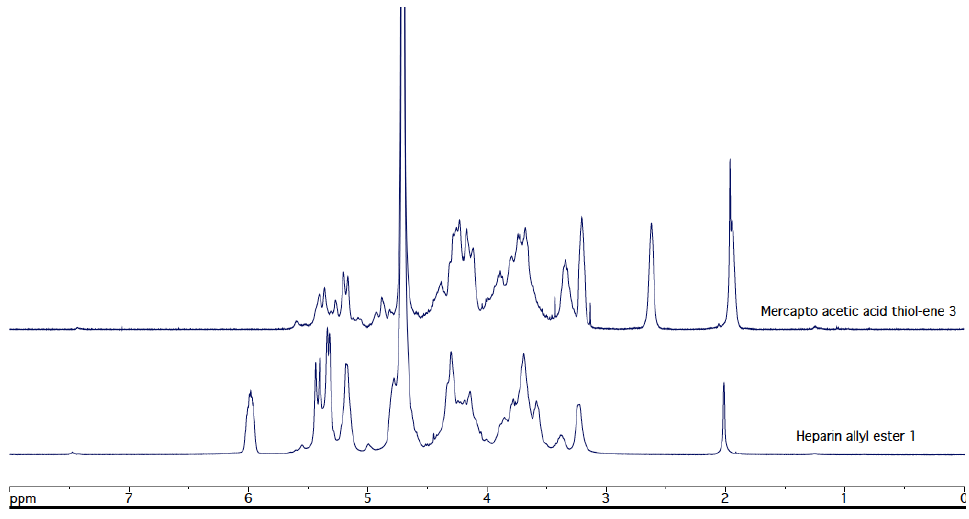
Figure 5. Stacked HNMR spectra of [1] and thiol-ene reaction with mercaptoacetic acid ( 3 ).